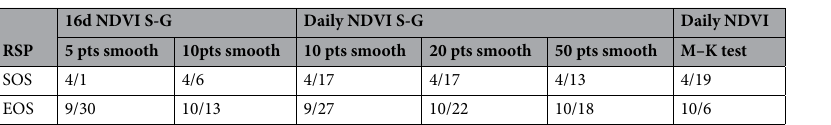
Table 6. Comparison of results of different data sources and different RSP determination methods (Month/